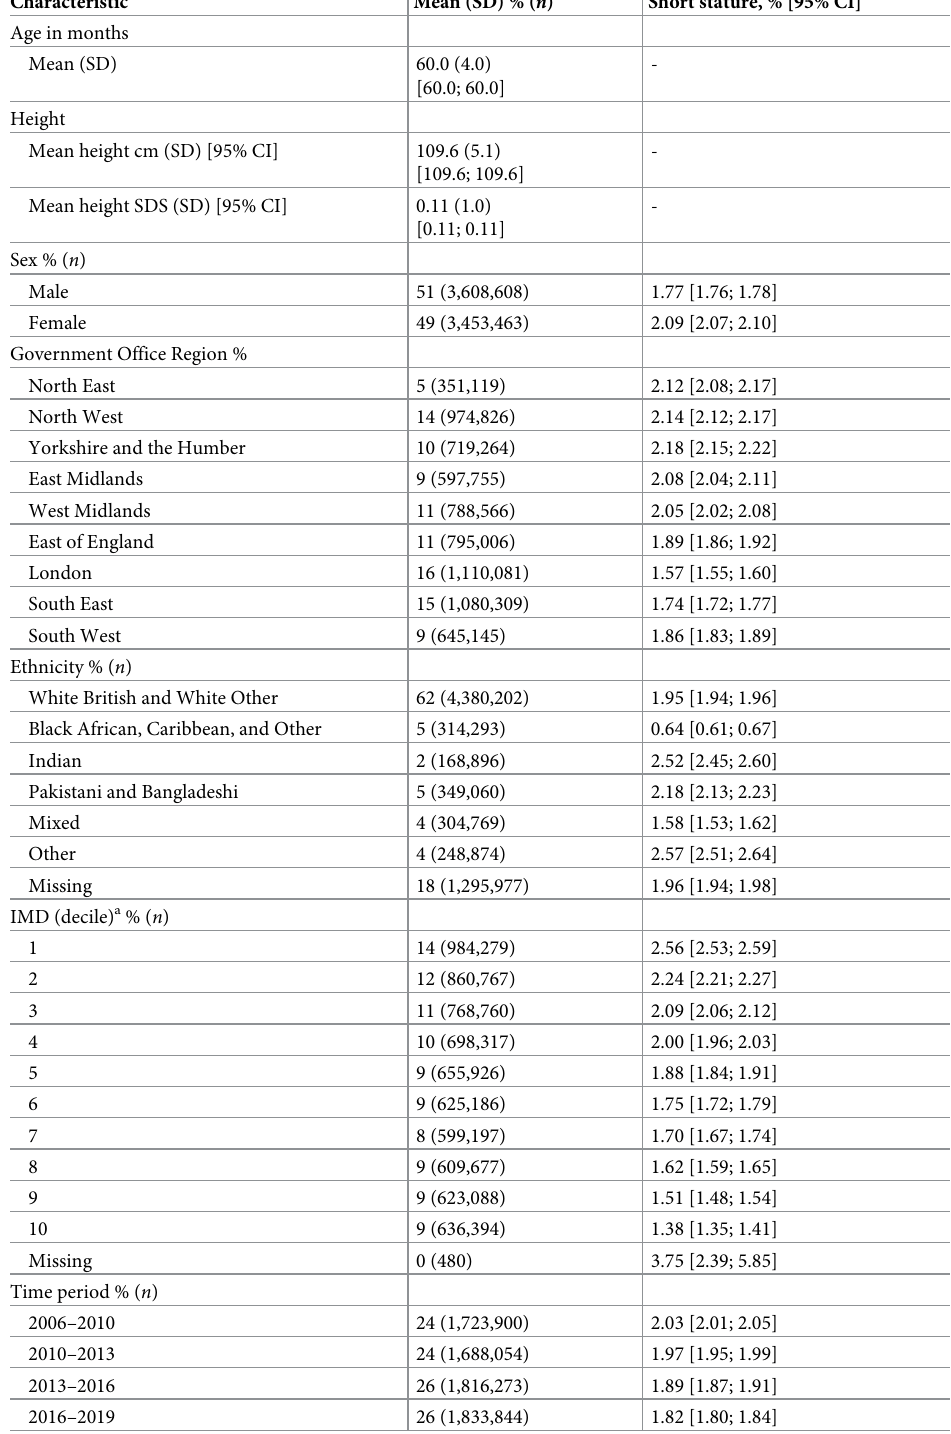
Table 1. Short stature (height < − 2.0 SDS) prevalence by sample characteristics ( n = 7,062,071).